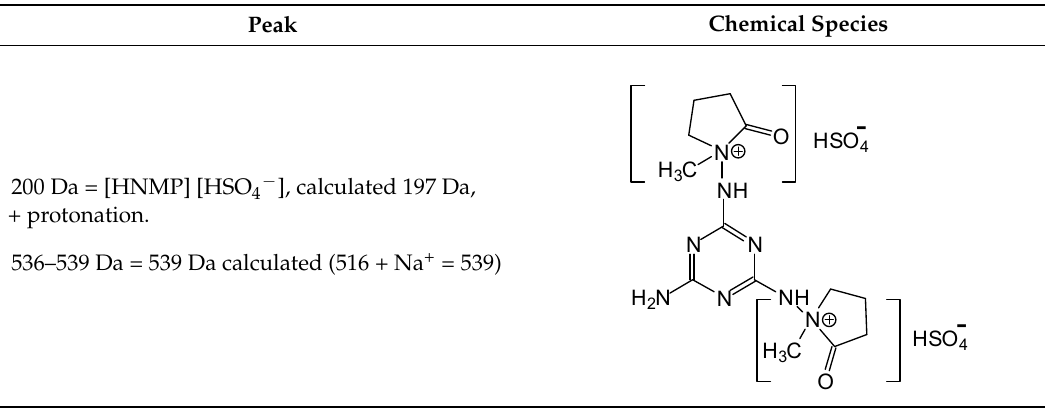
Figure 5. MALDI-ToF spectrum of the interaction between melamine and N -methyl-2-pyrrolydone